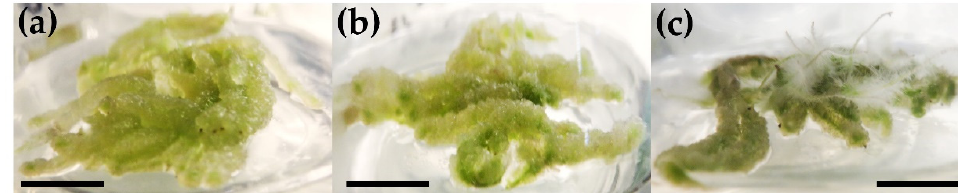
Figure 5. Morphogenetic responses of root explants after 10 days of their incubation: ( a ) KIN (0.1 mg/L) with 2,4-D (1.0 mg/L), ( b ) KIN (0.1 mg/L) with NAA (1.0 mg/L), ( c ) KIN (0.1 mg/L) with 2,4-D (0.1 mg/L). Scale bar = 10 mm.